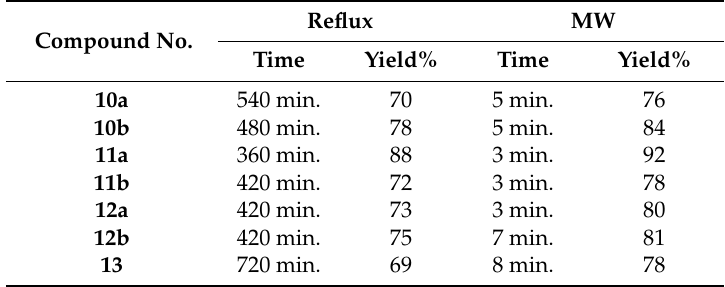
Table 2. Comparison between methods for the synthesis of compounds 10a , b – 13 . Compound